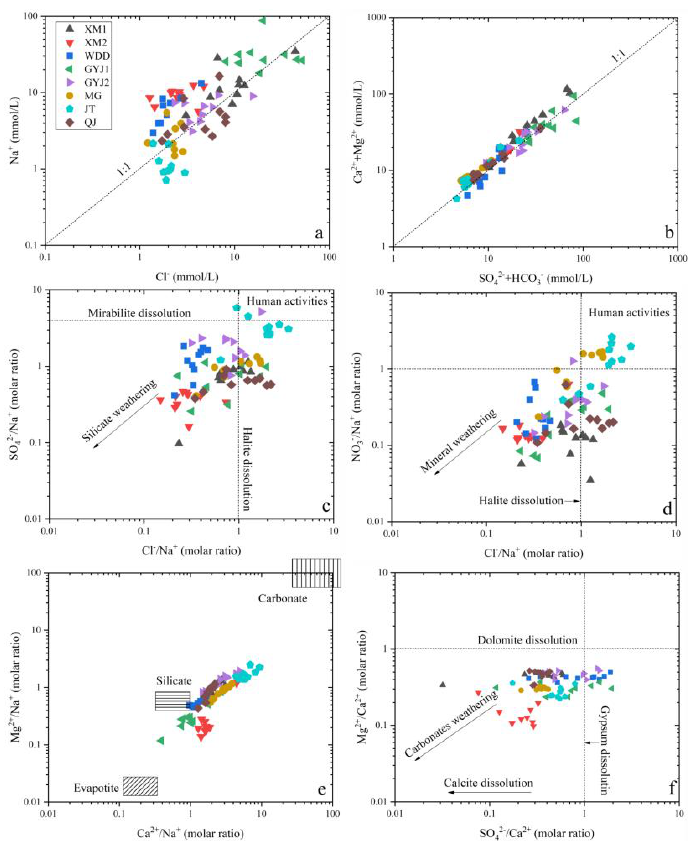
Figure 6. Major ions pairs of soil − soluble salt from the soil profiles (a is for Na + vs. Cl − , b is for Ca 2+ + Mg 2+ vs. SO 4 2− + HCO 3 − , c is for SO 4 2− /Na + vs. Cl − /Na + , d is for NO 3 − /Na + vs. Cl − /Na + , e is for Mg 2+ /Na + vs. Ca 2+ /Na + , and f is for Mg 2+ /Ca 2 + vs. SO 4 2− /Ca 2+ , respectively).